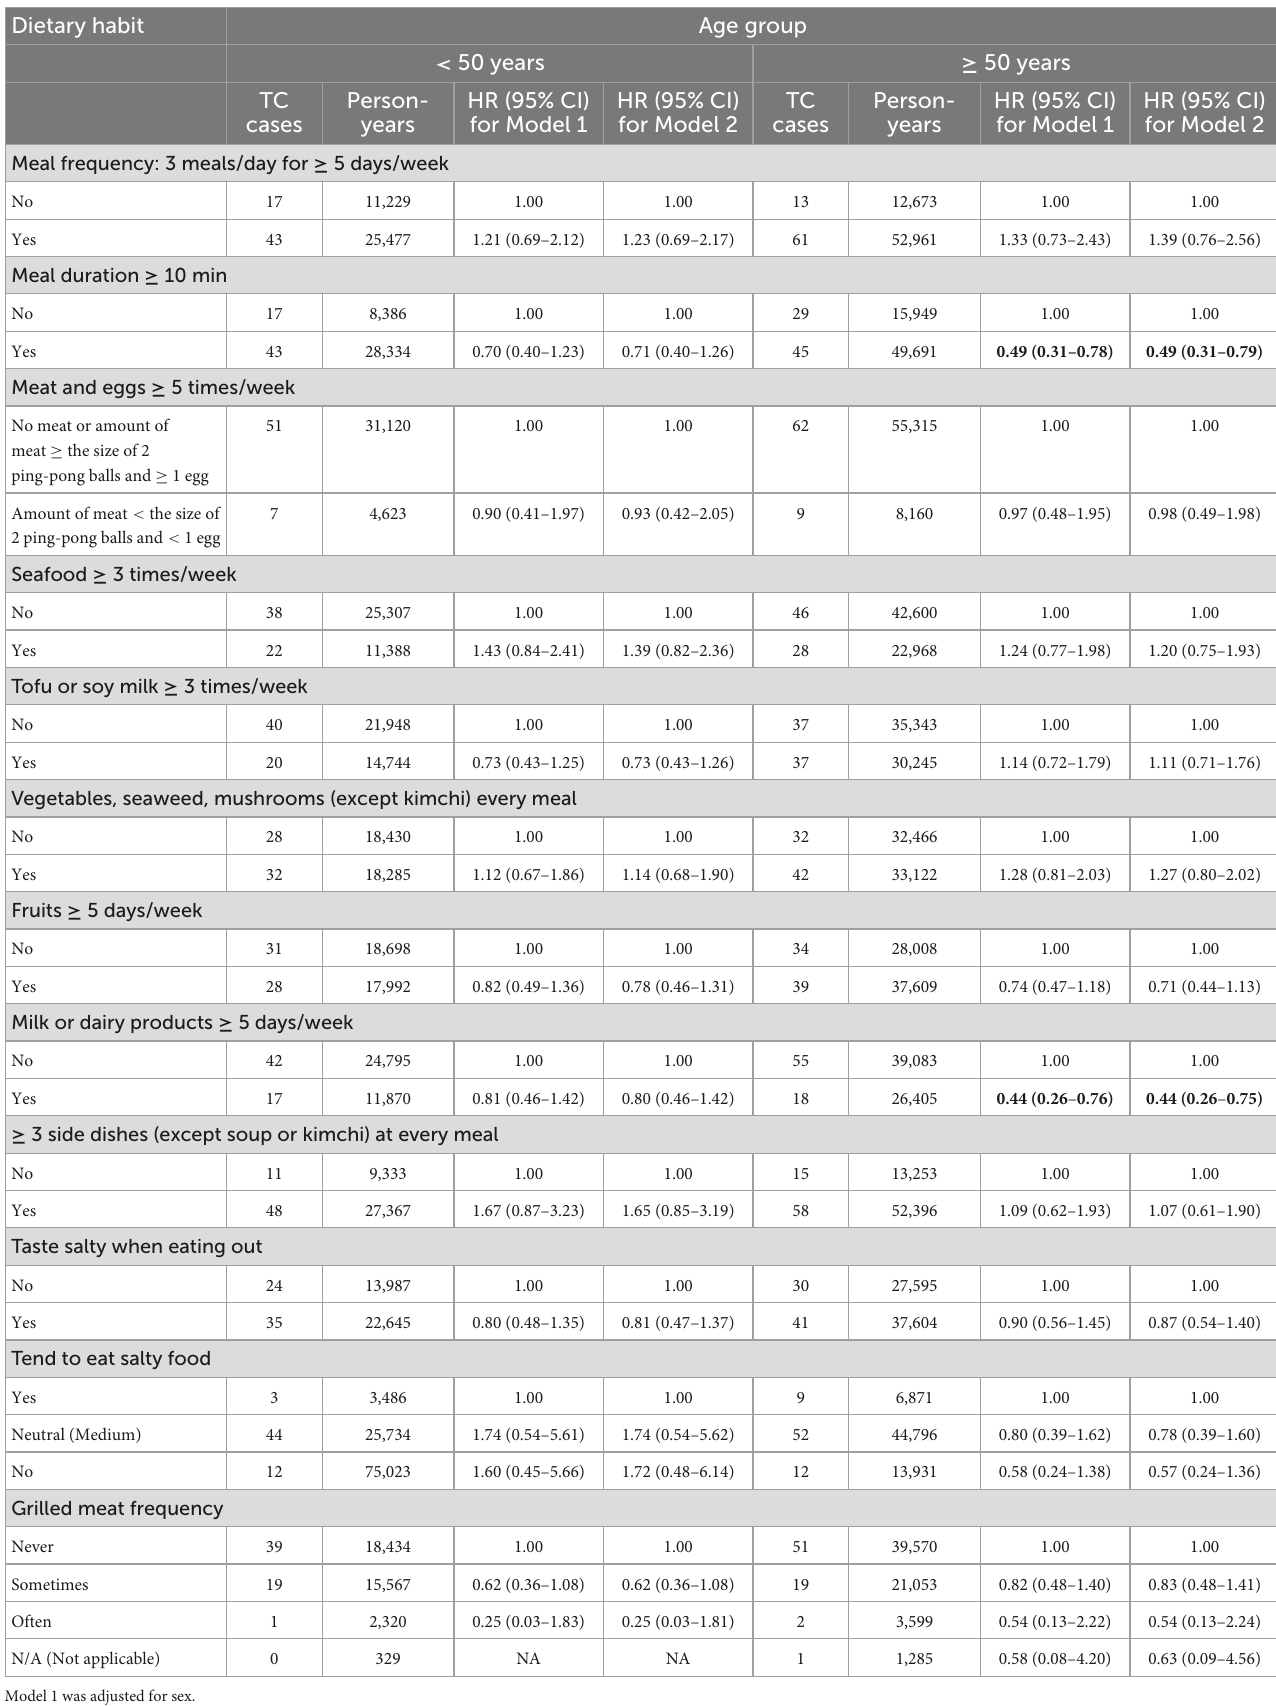
TABLE 3 Hazard ratios (HRs) and 95% confidence intervals (CIs) of incident thyroid cancer (TC) related to dietary habits by stratification of age. Dietary